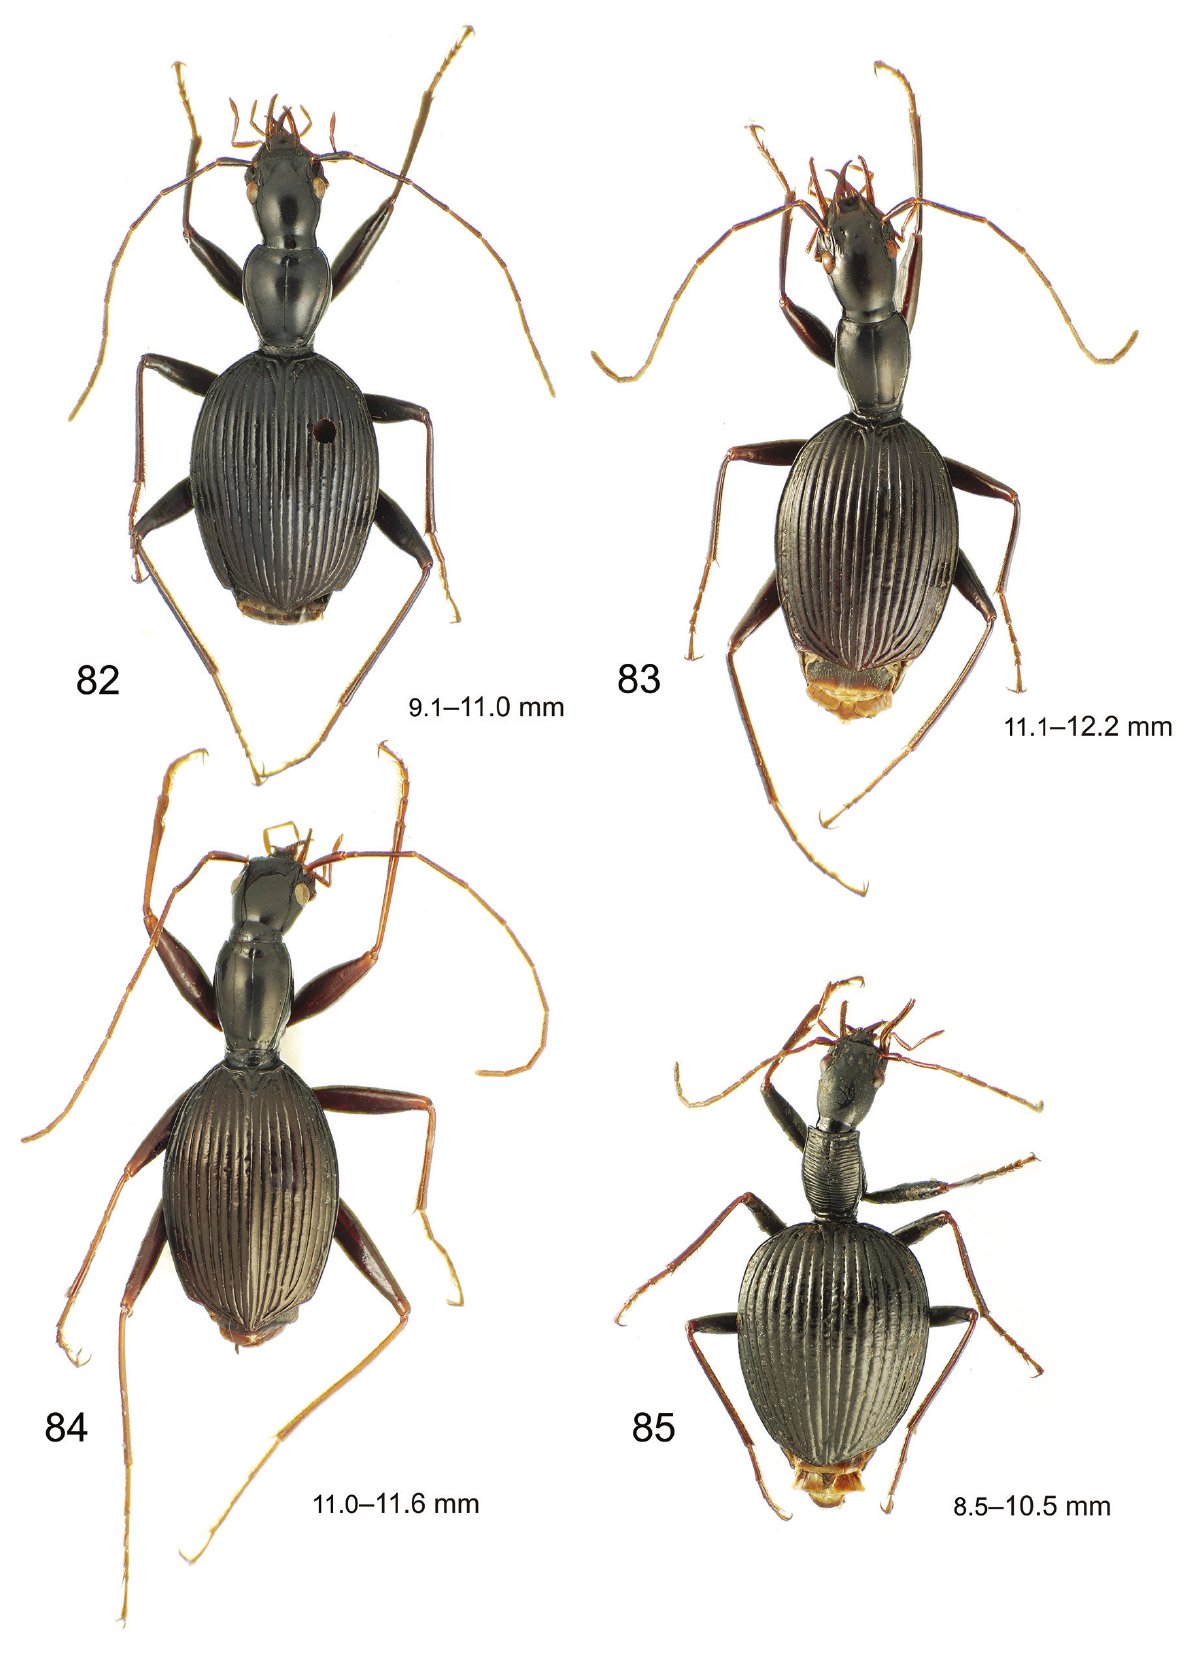
Figures 82–85. Dorsal habitus photographs of Cyphocoleus spp.: 82 , C. ovicollis female, Ningua Res.; 83 , C. burwelli female, Mt. Canala; 84 , C. angustatus male, Mt. Panié; 85 , C. monteithi male, Dzumac Rd.